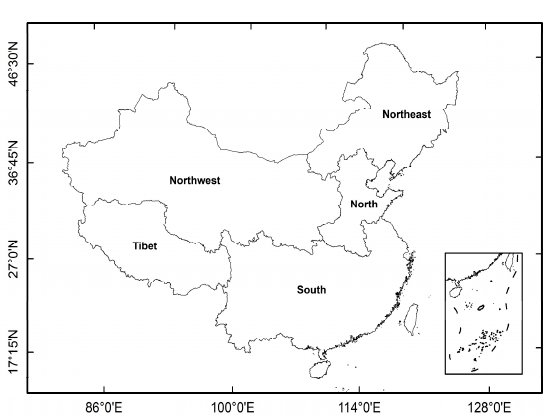
Figure A1. The geographic division of China used in this review.